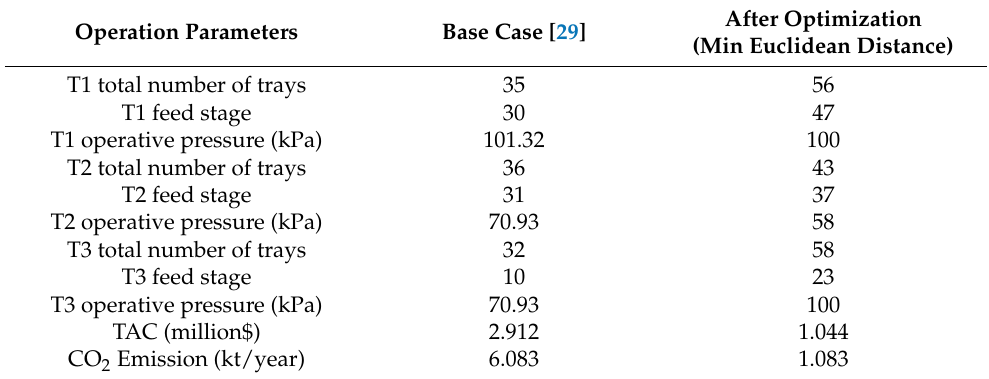
Table 5. Comparison between initial results and NSGA-II-DE optimization results. Operation Parameters Base Case [29]